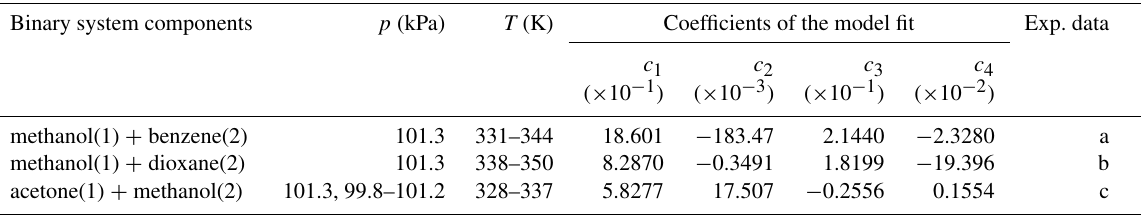
Table 7. Coefficients for the Duhem–Margules excess Gibbs energy model (McGlashan, 1963; Soonsin et al., 2010) fitted to salt-free binary organic solvent mixture data. Binary system